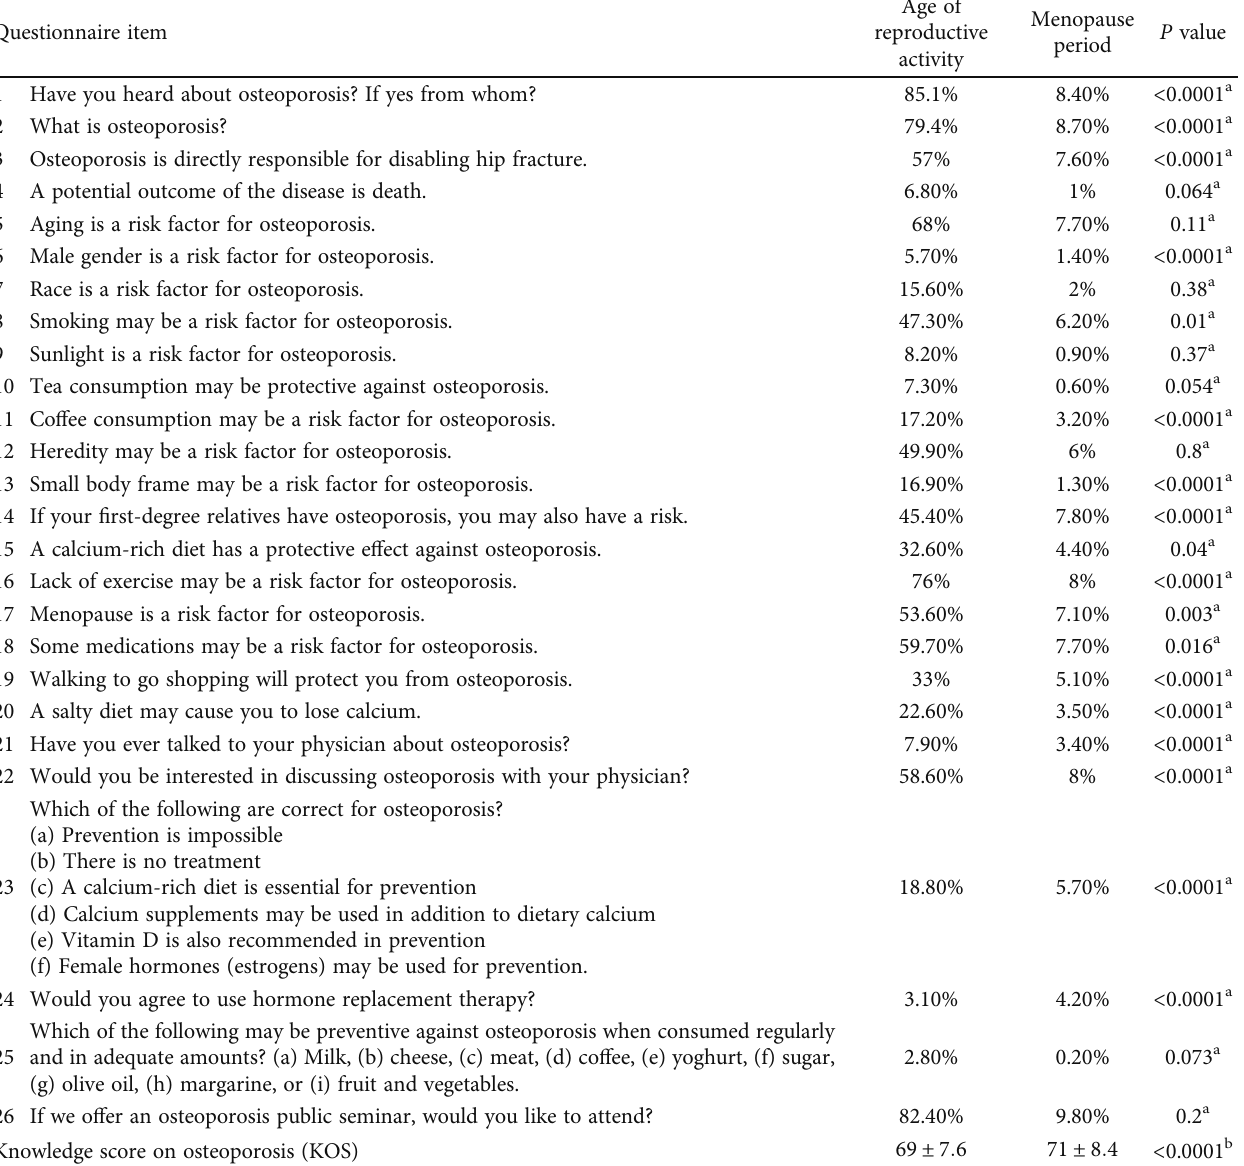
Table 3: The di ff erences in awareness towards osteoporosis, between women in the reproductive age group and the menopausal age group. Questionnaire